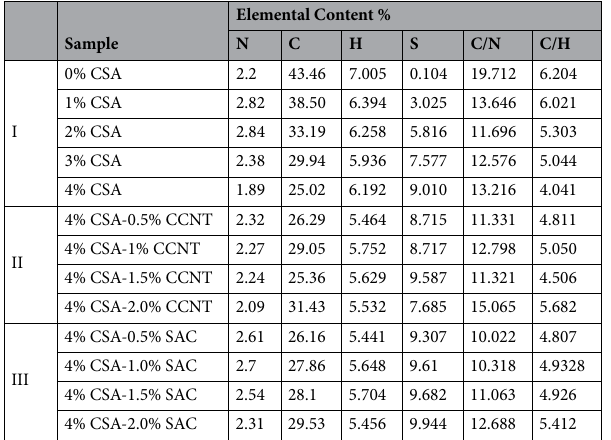
Table 2. Elemental composition of CMC/PVA/AA-based hybrid polyelectrolytic membranes with different concentrations of CSA, CCNT and